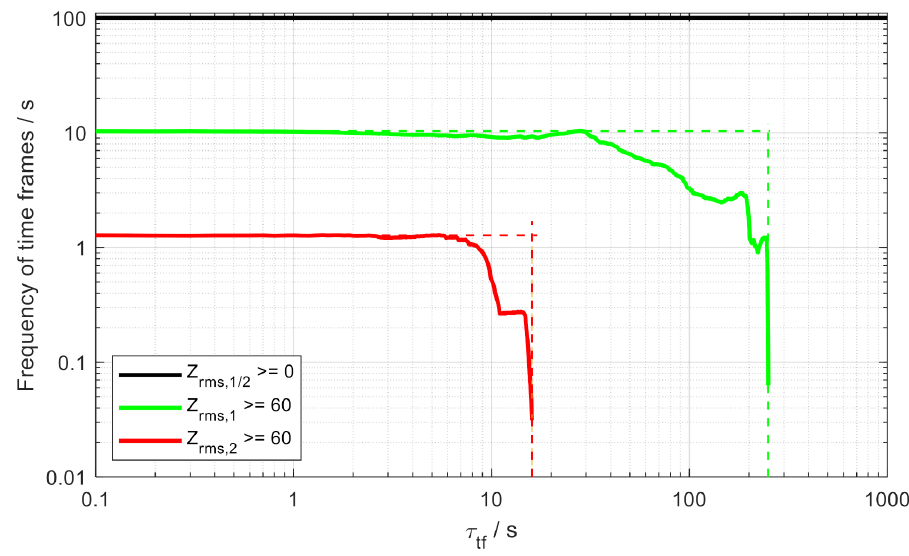
Figure 6. Exemplary frequency of time